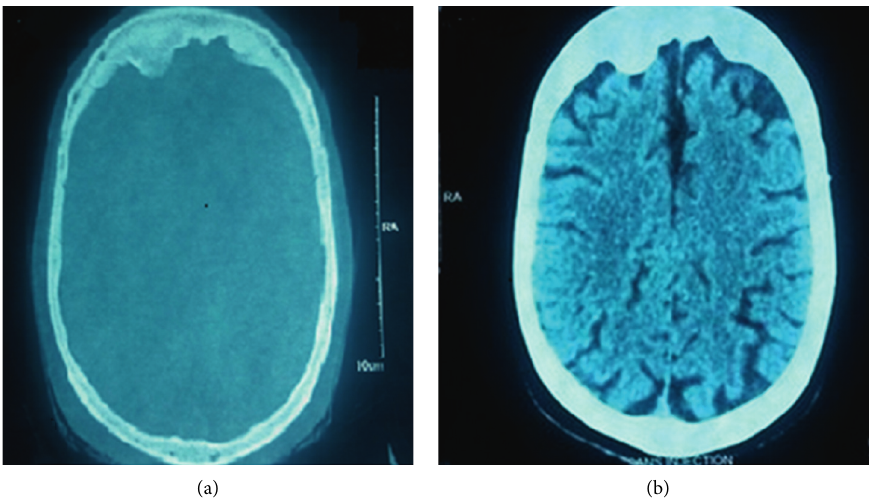
Figure 2: (a) Axial cranial computed tomography scan illustrating the bilateral and asymmetrical thickening of the inner table of the frontal bone. (b) Axial cranial computed tomography scan illustrating the frontal